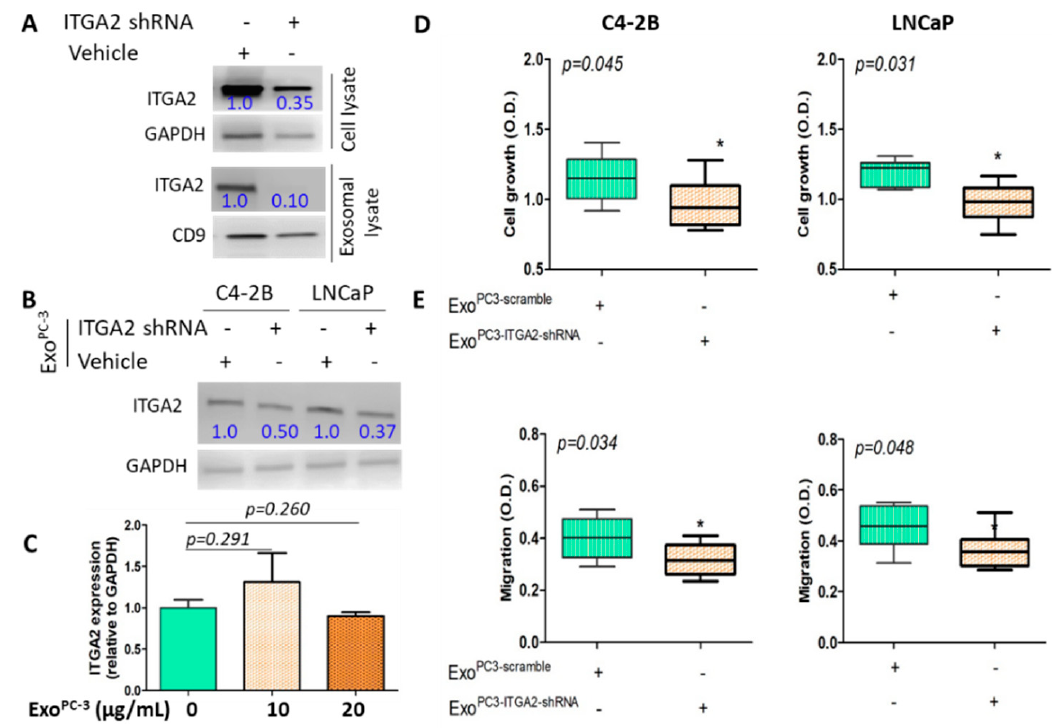
Figure 3. Knockdown of ITGA2 in PC-3 cells suppresses the effect of exosomes on recipient C4-2B and LNCaP cells. ( A ). PC-3 cells were transduced with shRNA specific to ITGA2 in addition to scrambled control. Immunoblot (IB) analysis was performed to examine the expression of ITGA2 in total cell and exosomes lysates. ( B ). C4-2B and LNCaP cells were incubated with 20 µg/mL exosomes derived from ITGA2 knockdown PC-3 cells. ( C ) C4-2B cells were incubated with 10 and 20 µg/mL exosomes derived from ITGA2 knockdown PC-3 cells for 24 h. RNA was extracted and real-time PCR was performed to determine the expression of ITGA2 relative to gapdh . ( D , E ) C4-2B and LNCaP cells were incubated with exosomes isolated from the integrin knockdown PC-3 cells and cell proliferation and migration assays were assessed. Data considered significant at p < 0.05. The experiment was repeated twice.